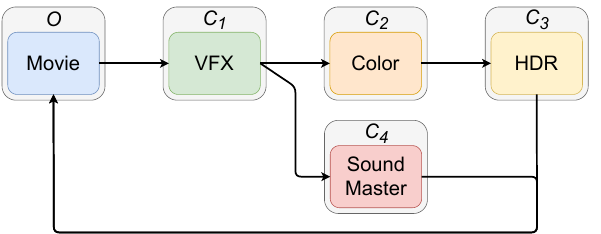
Figure 1. Movie workflow example. Arrows model the specified workflow, and thus represent the communication flow of our example. The owner ( O ) sends its data to the first contractor ( C 1 ), for special effects processing. C 1 then sends the modified data along the workflow, for color ( C 2 ), HDR ( C 3 ) and sound ( C 4 ) processing. The resulting data are then sent back to the